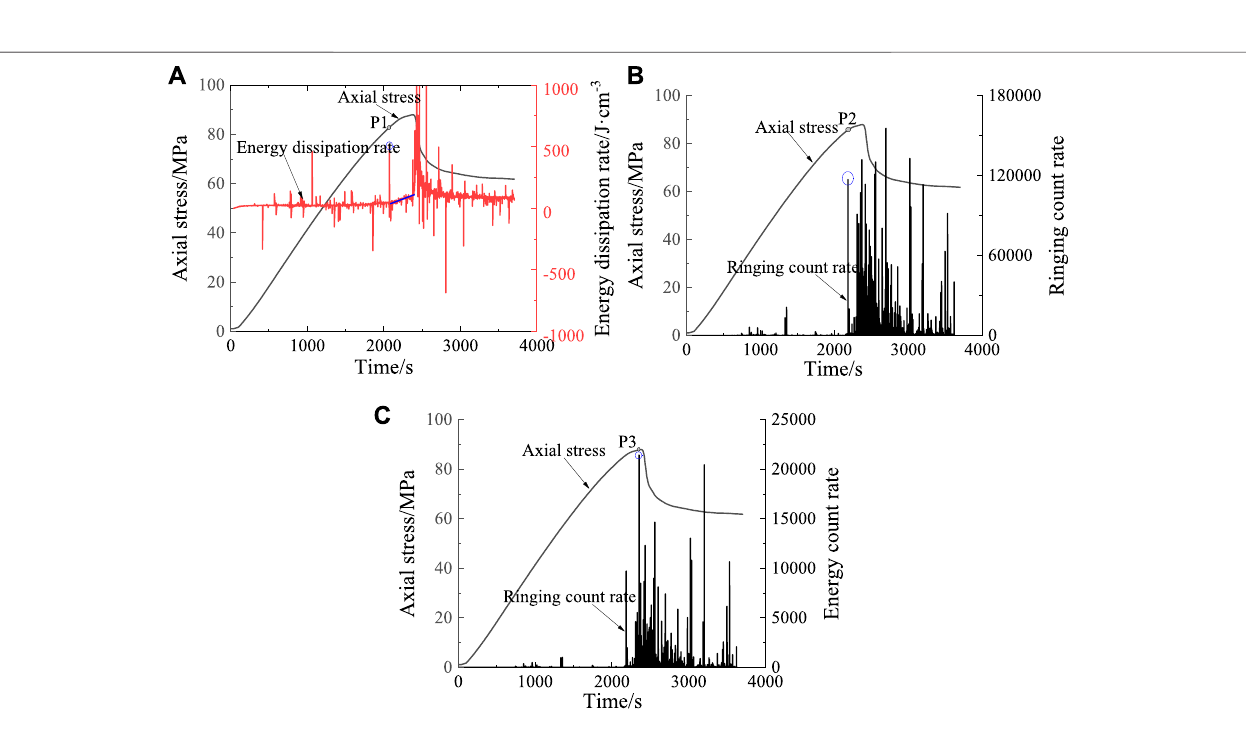
Frontiers in Earth Science |